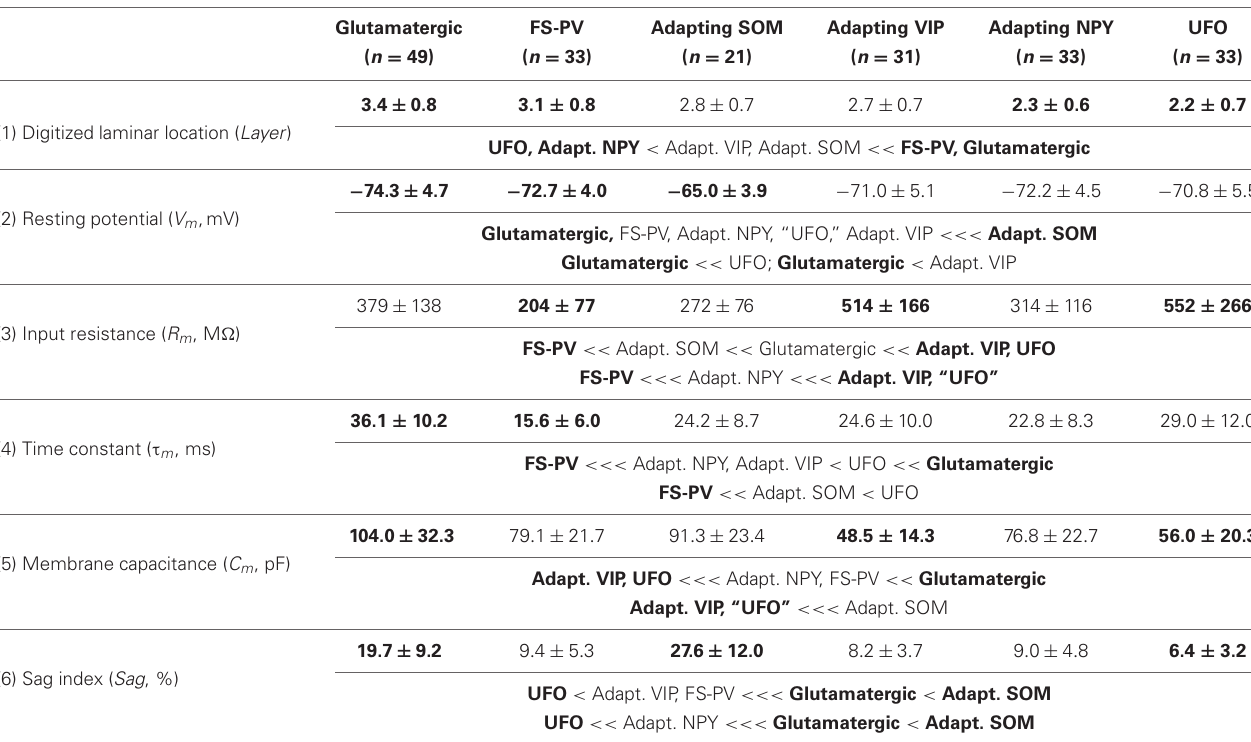
Table 1 | Localization and subthreshold features of different